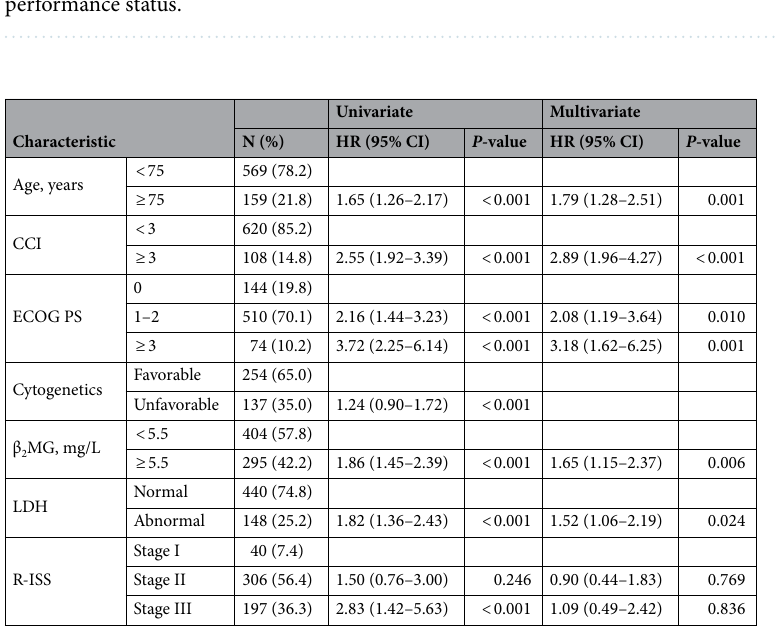
Table 3. Univariate and multivariate analyses of overall survival. OS , overall survival; HR , hazard ratio; 95% CI , 95% confidence interval; CCI , Charlson comorbidity index; ECOG PS , Eastern Cooperative